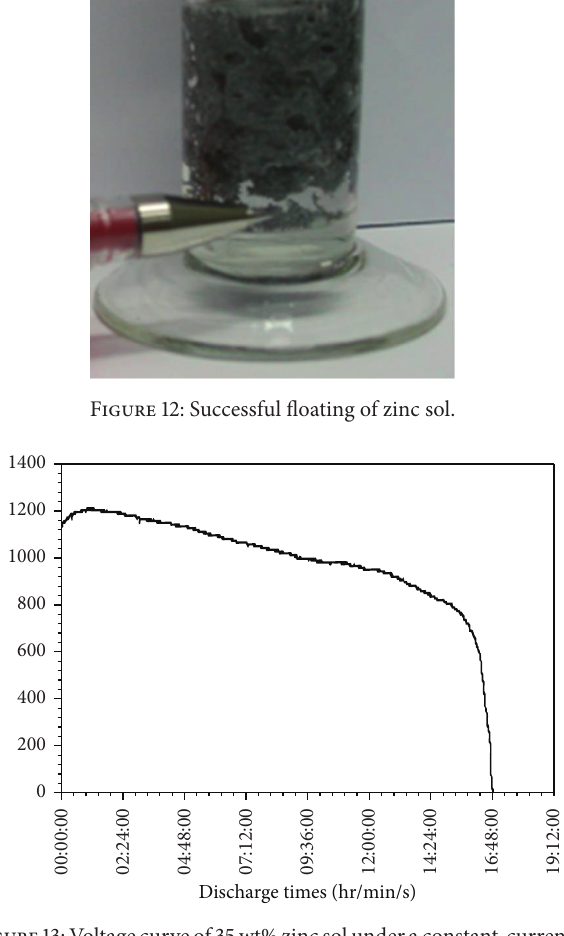
Figure13:Voltagecurveof35 wt%zincsolunderaconstant-current discharge at 200